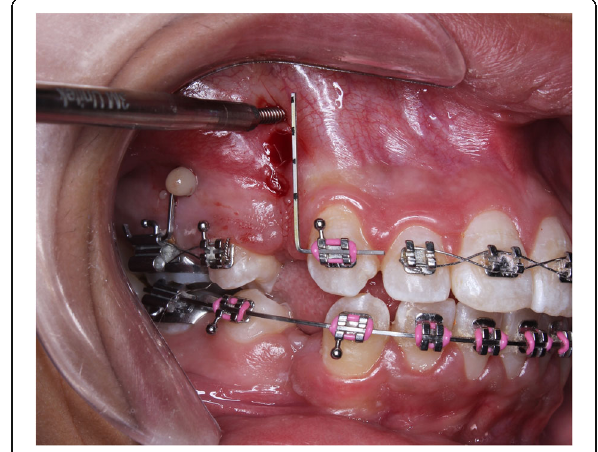
Fig. 1 Intra-oral photograph showing the procedure of MOPs using a TAD (note the permanent marks on the vertical segment of the wire guide dividing two thirds of the canine root length into equal thirds, such that one MOP was performed for each